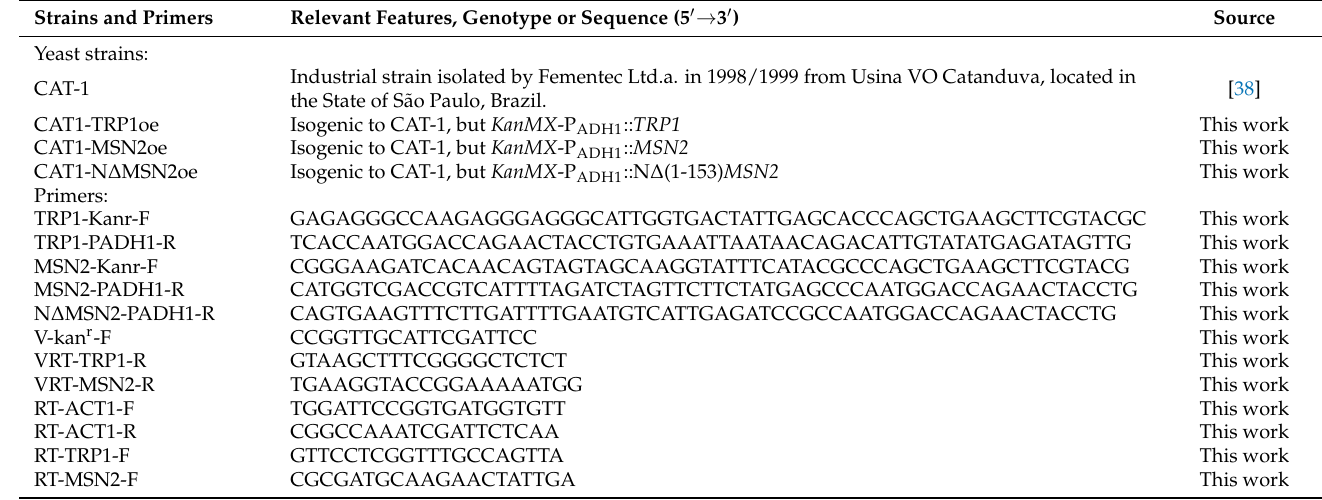
Table 1. Yeast strains and primers used in this